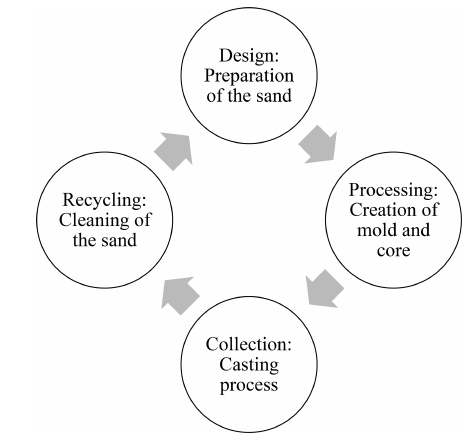
Figure 2. Circular raw material utilization (raw material cycle) with the sand cycle from the foundry industry as an